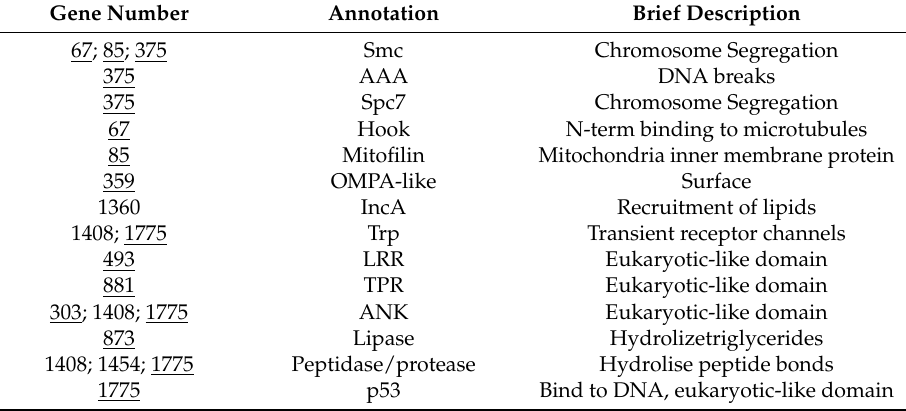
Table 2. Functional domains found in the 35 candidate genes. Underlined genes are present in the f